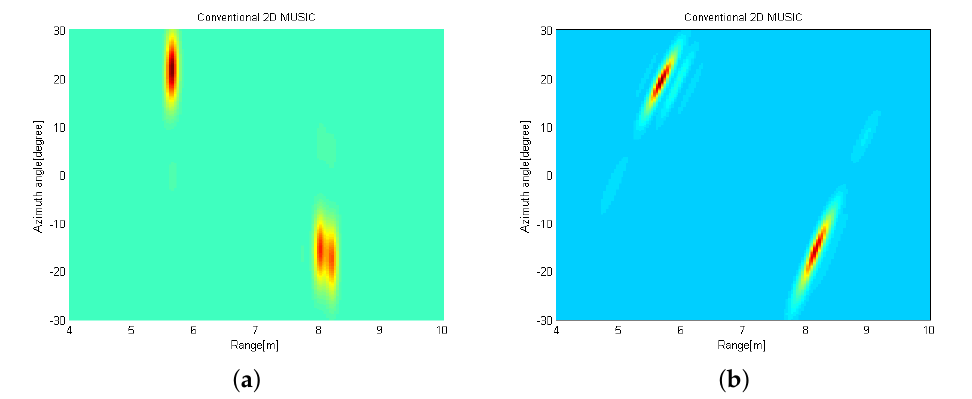
Figure 11. Radar images ( a ) at reference radar by using the conventional 2D MUSIC and ( b ) at distributed radar by using the conventional 2D MUSIC with coordinate transformation.